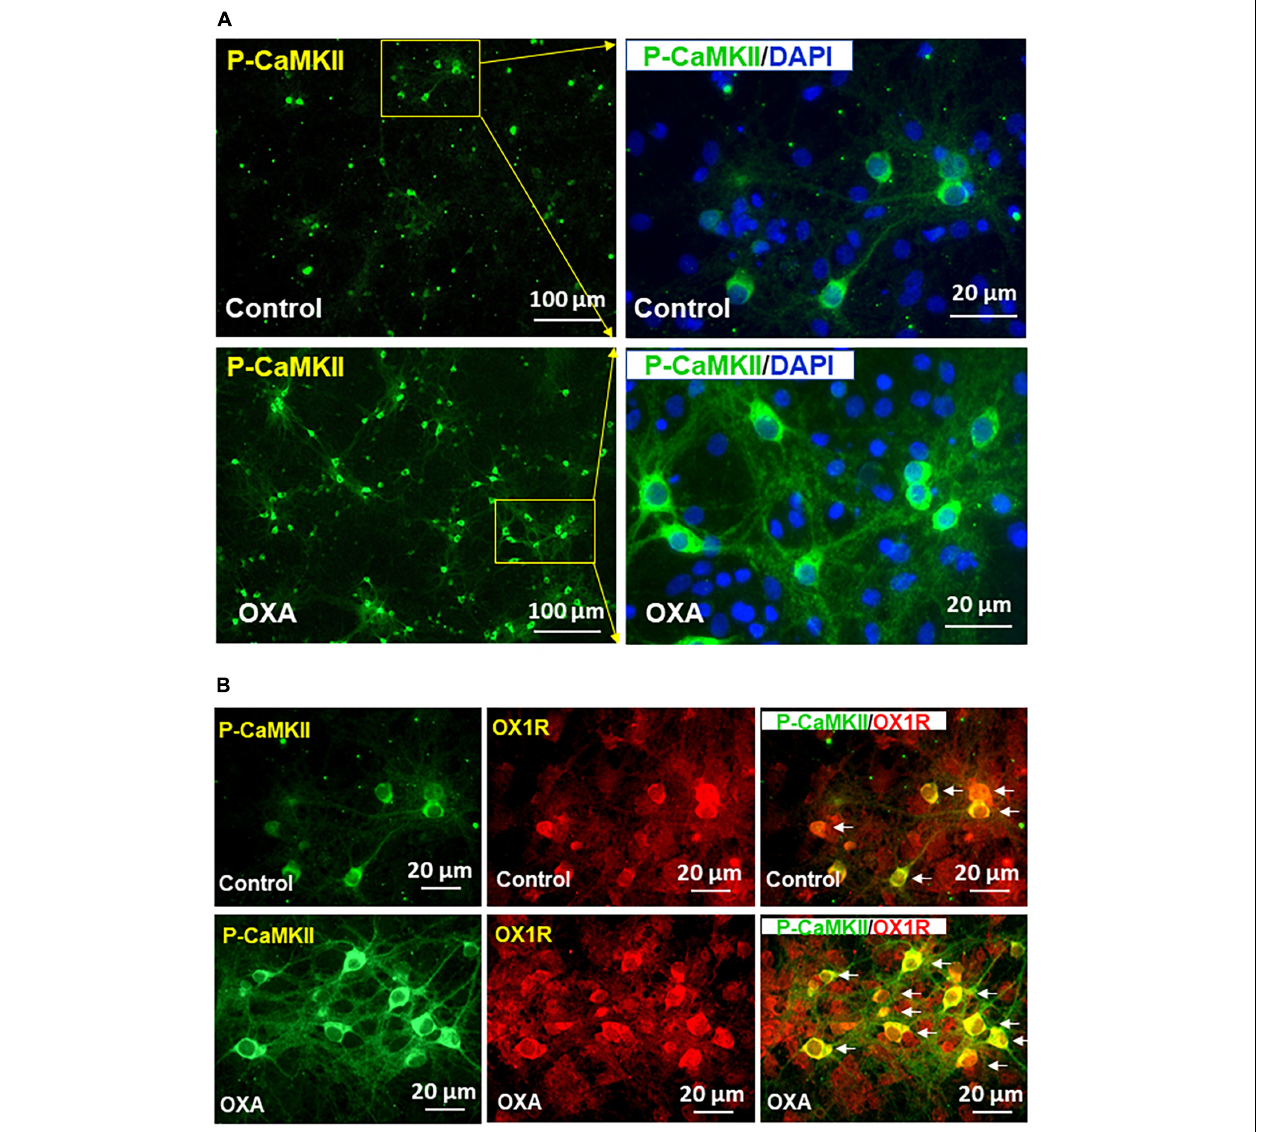
FIGURE 5 | Orexin-A treatment increases CaMKII activation in OX1R-expressing hypothalamic neurons. Hypothalamic neuronal cultures isolated from neonatal SD rats were treated with 1 µ M of orexin-A or vehicle control for 15 min, then cells were subjected to immunostaining using primary antibody anti-phospho-CaMKII (P-CaMKII) or OX1R followed by incubation with fluorescent dye-labeled secondary antibody. (A) Orexin-A treatment increases P-CaMKII in hypothalamic neurons. The area labeled in a solid rectangle in the left panel was higher magnified in the right panel. (B) Representative images show the immunostaining of P-CaMKII (green), OX1R (red), and merged image in cultured PVN neurons under orexin-A